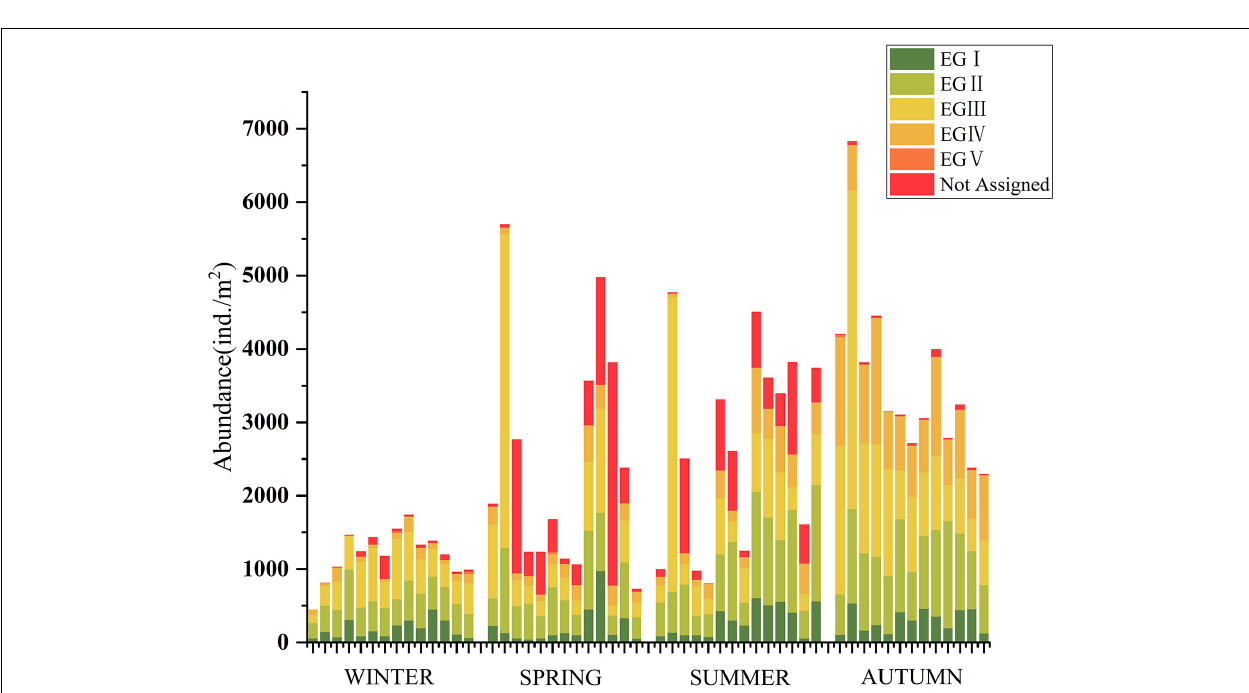
FIGURE 7 | Abundance of groups at different sites of four cruises based on the AMBI species list in Jiaozhou Bay. EGI–EGV: ecological groups I–V based on AMBI species list. Not assigned: the unassigned species based on AMBI species list.